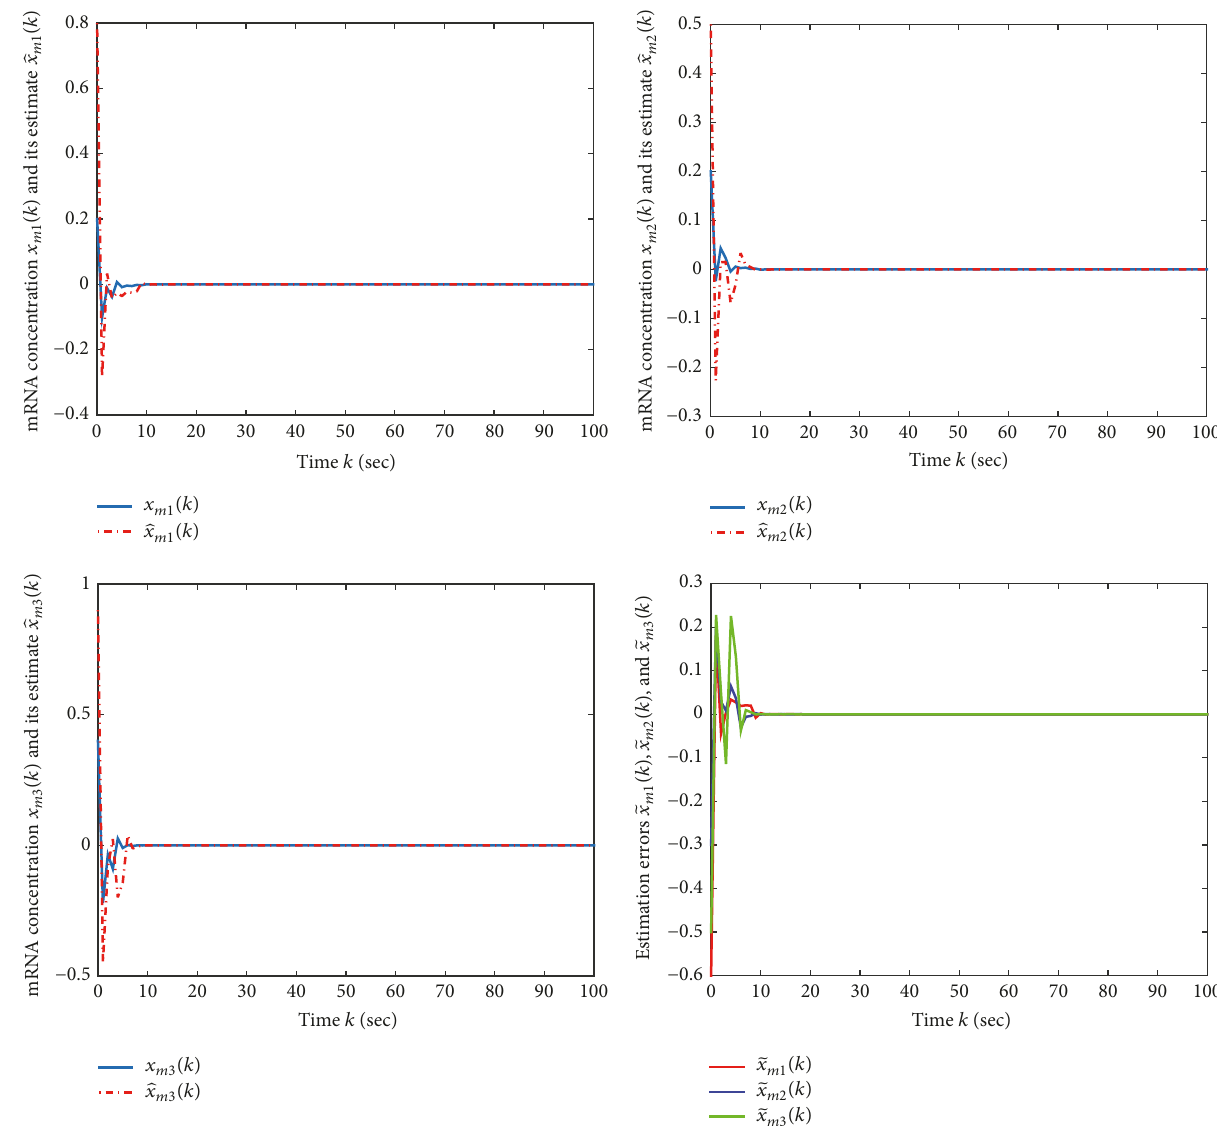
Figure 1: mRNA concentrations, its estimates, and the estimation error of Example 1.